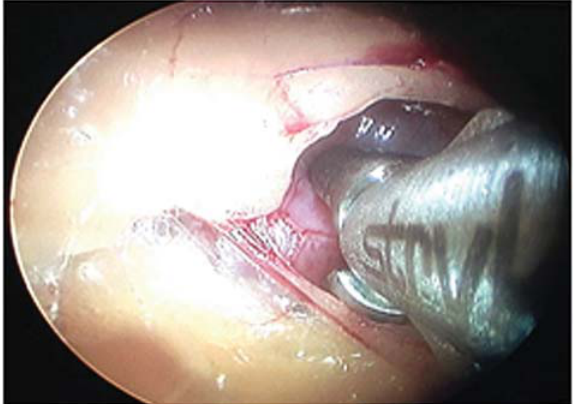
Figure 2 - Sampling renal parenchyma with a toothed biopsy forceps, through the nephroscope working